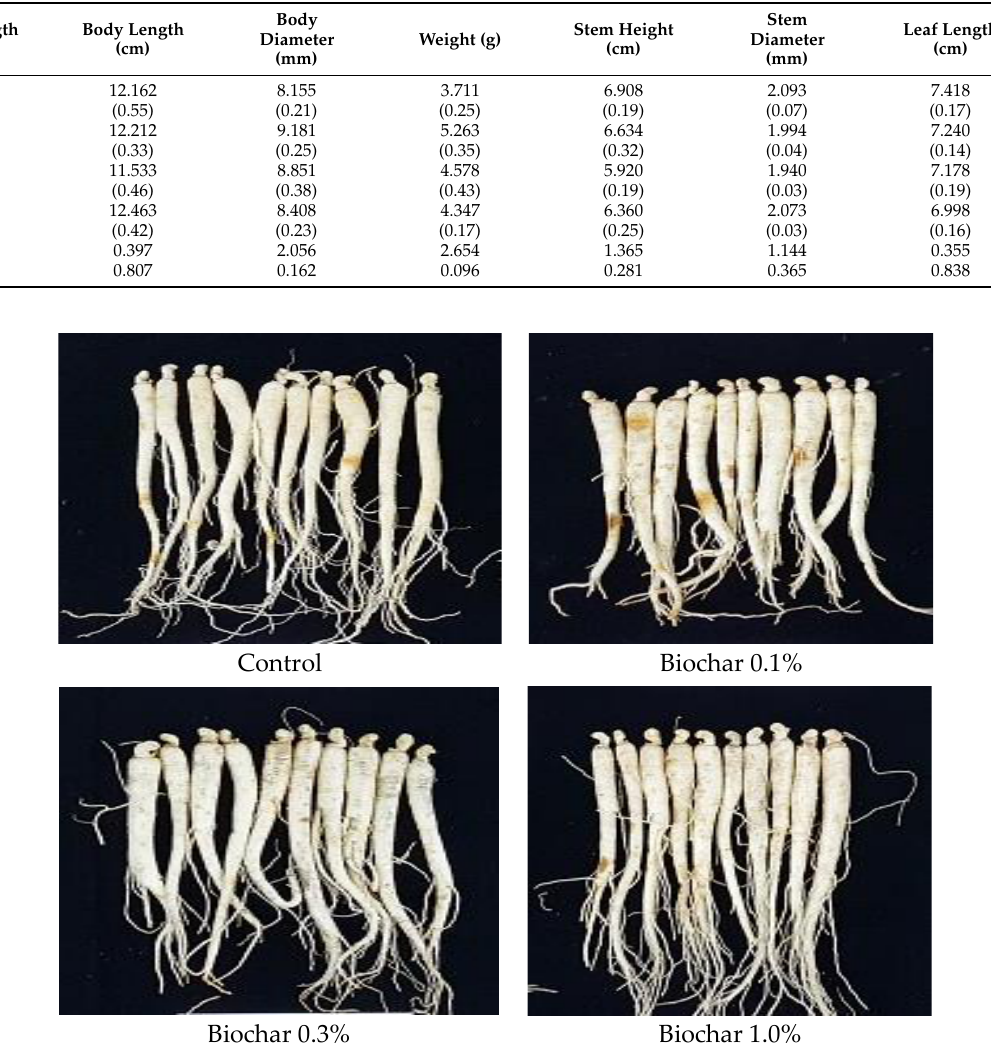
Table 6. Comparison of ginseng quality evaluation by biochar treatment (average of each treatment with standard error).